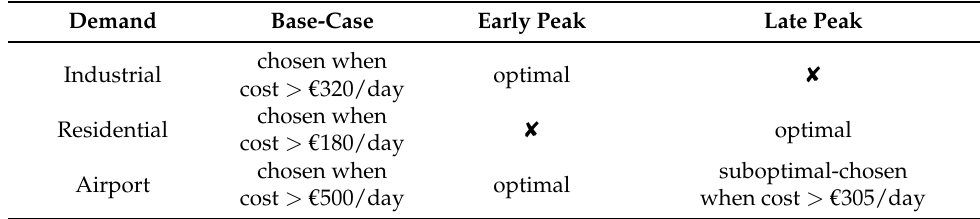
Table 2. Demand profile choice at non-zero